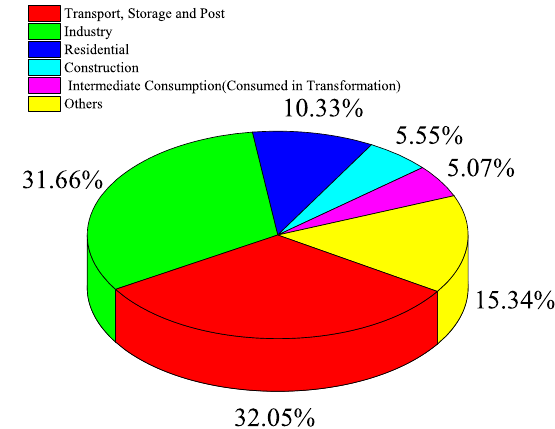
Fig. 1 The proportion of China’s petroleum consumption by sector in 2008